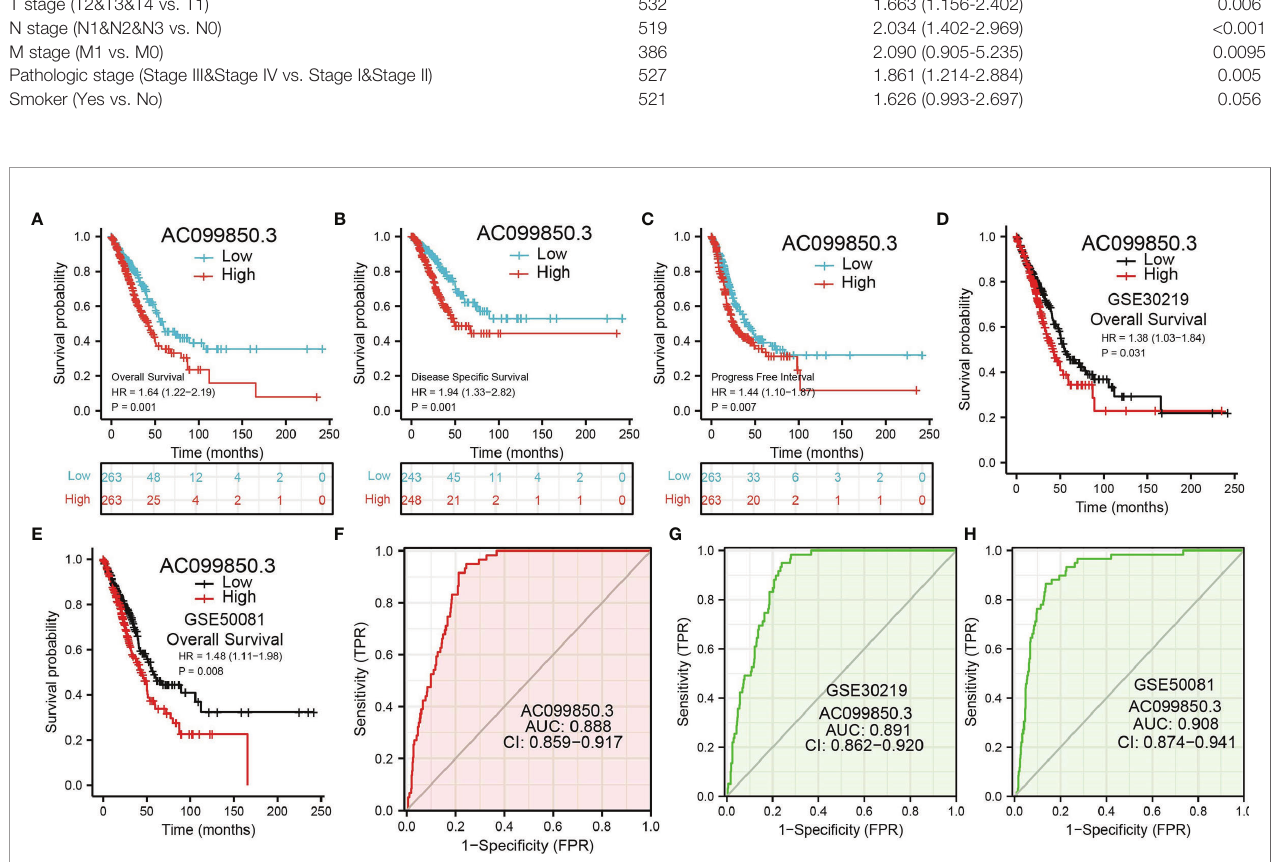
TABLE 2 | Logistic regression analysis of correlation between AC099850.3 expression and clinical pathological characteristics. Characteristics Total (N) T stage (T2&T3&T4 vs. T1)